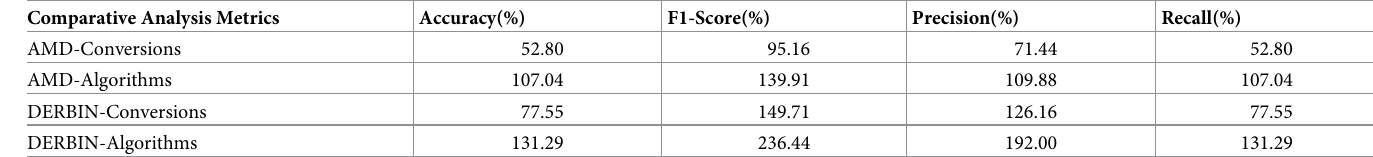
Table 7. Comparative analysis: Percentage of the highest improved performance among different CNN models per metric and dataset type. Comparative Analysis